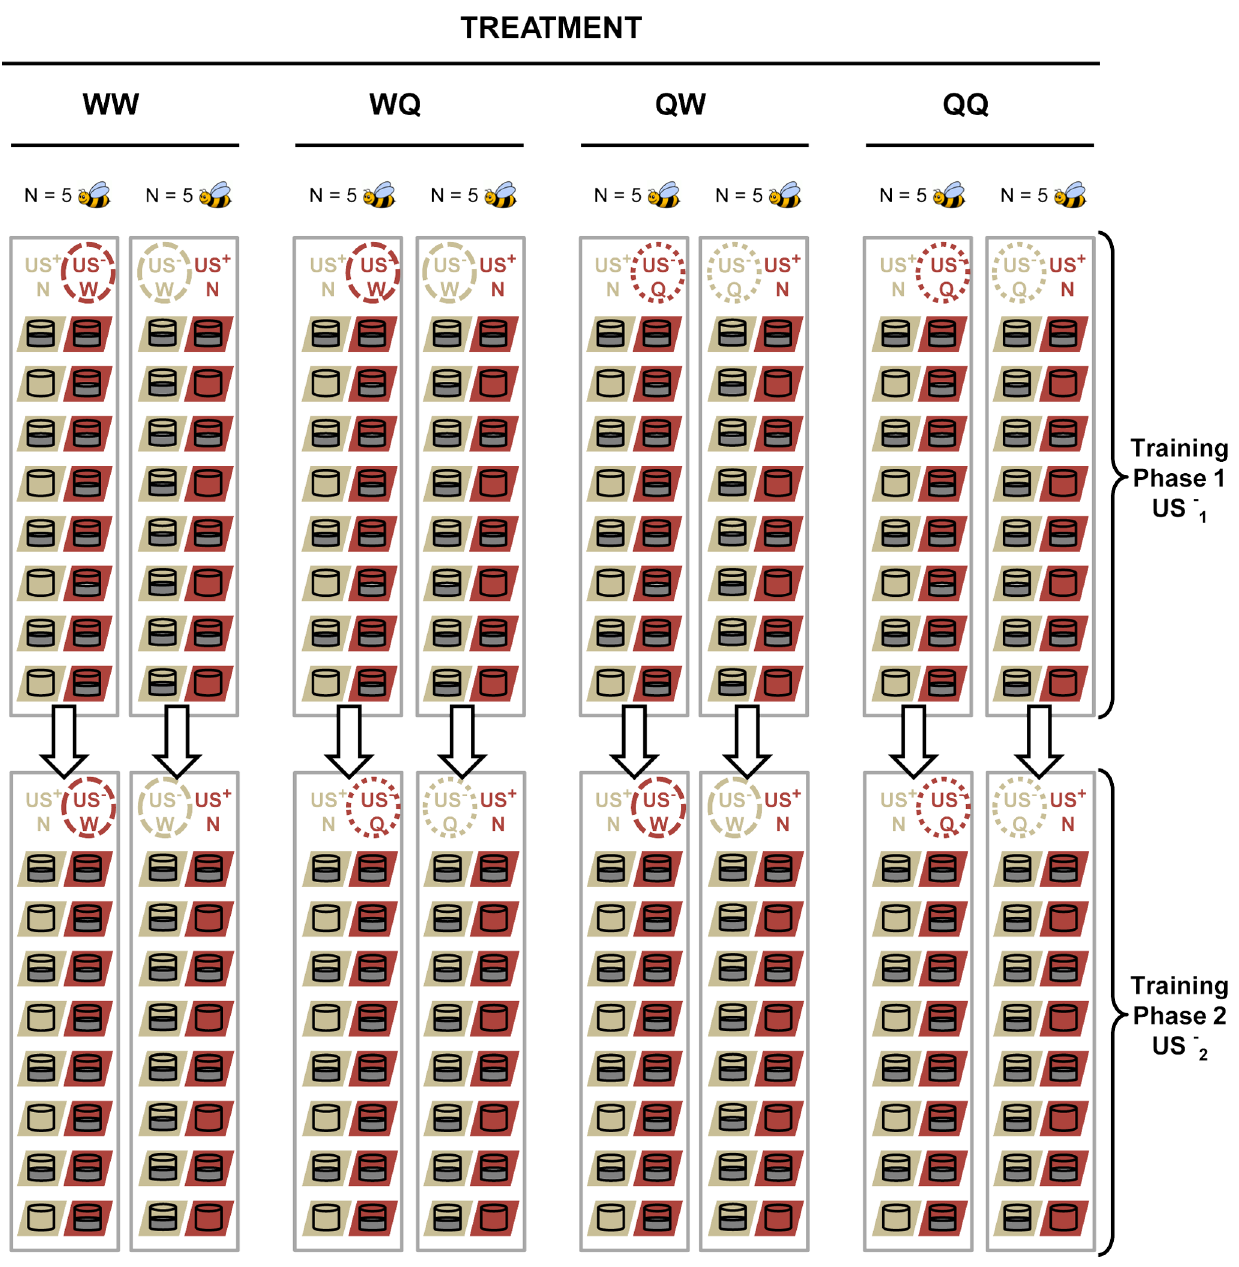
Figure 3. Experimental design. Combinations of unconditioned (US) and conditioned (CS) stimuli experienced by the bees during training. Each rectangular box indicates the contents of the flight arena at the beginning of each trial, for bees in the different treatments (represented by columns) in each experimental phase (top and bottom rows for phases 1 and 2, respectively). We studied the effect on learning of four reinforcement schedules, characterized by different choices of the US-. The US- could be water (W) or quinine (Q) during the whole experiment, or change from one to the other halfway through the experiment, accounting for the four experimental treatments: WW, WQ, QW and QQ. Regardless of the treatment, bees entering the arena encountered eight distractor flowers (US- column in each rectangular box), each one containing ca. 25 m l of the US- (represented by ‘‘filled cups’’), and eight target flowers (US + column). Four target flowers were empty (empty cups) and the other four contained ca. 25 m l of the US + (sucrose solution – filled cups). Note that, in the experiment, distractor and target flowers were haphazardly distributed throughout the arena. Distractor and target flowers were identified by the colour squares (CS + and CS-) on which they were set (represented by the cream and reddish parallelograms in the figure). The squares were cut from Canson Mi-Teintes cardboard (refs. 133 and 336). Forty bees were allocated to the different treatments, 10 bees per treatment. Within each experimental group, colour # 133 was the CS + for five of the bees and the CS- for the other five. remotely by olfactory cues, the proportion of sucrose flowers visited would be greater than 0.5.